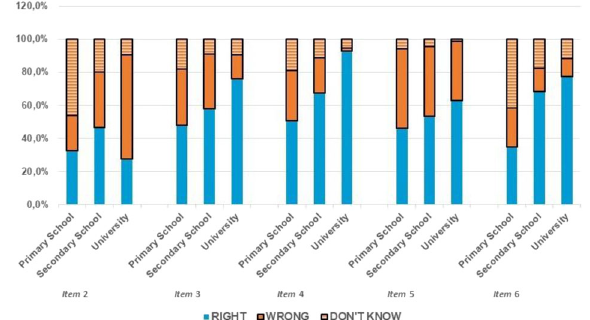
Fig. 3 Confusion regarding the usage of the terms “ weather and climate ” . The colors of the bars represent the student ’ s answers per item. Right answers are represented by “ RIGHT ” . Wrong answers are represented by “ WRONG ” . Not answered questions are represented by “ DON ’ T KNOW ” . We have combined the “ WRONG ” and “ DON ’ T KNOW ” answers to represent the degree of confusion regarding each item at each educational stage.